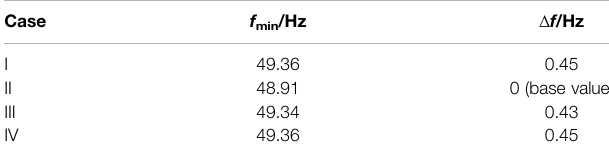
TABLE 3 | Minimum and relative improvement value of the system frequency in four